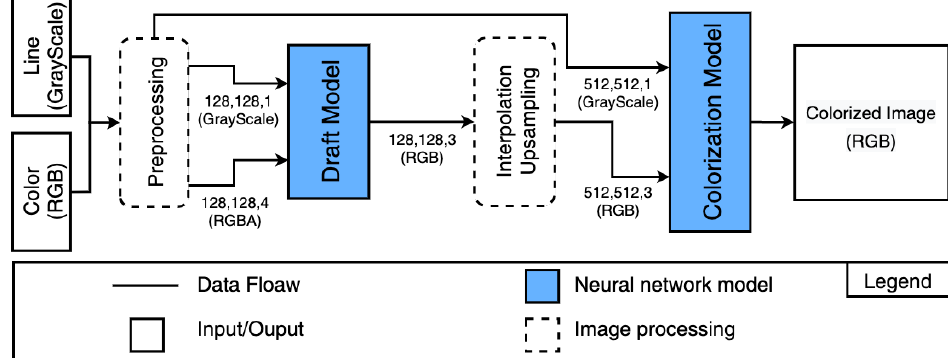
Figure 2. Network